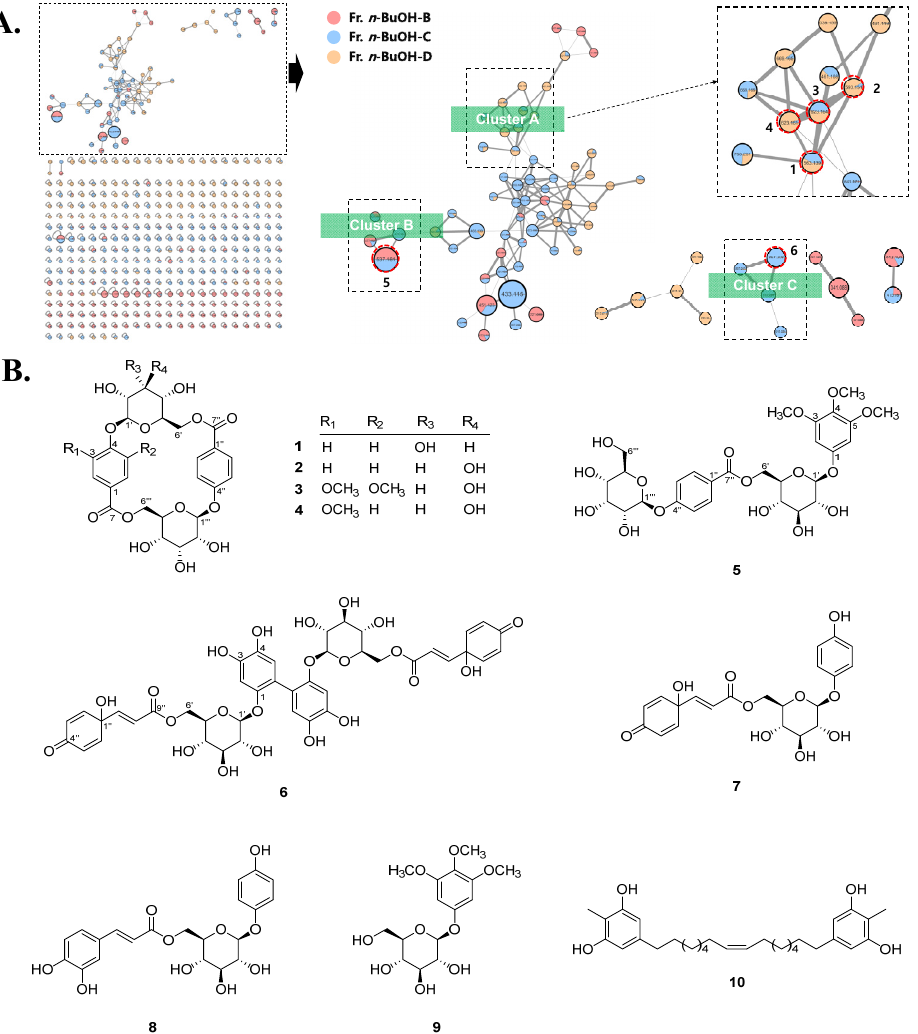
Figure 1. ( A ) LC-MS/MS molecular networking for the subfractions of the n -BuOH layer, and ( B ) chemical structures of compounds 1 – 10 isolated from the leaves of H. terminalis .